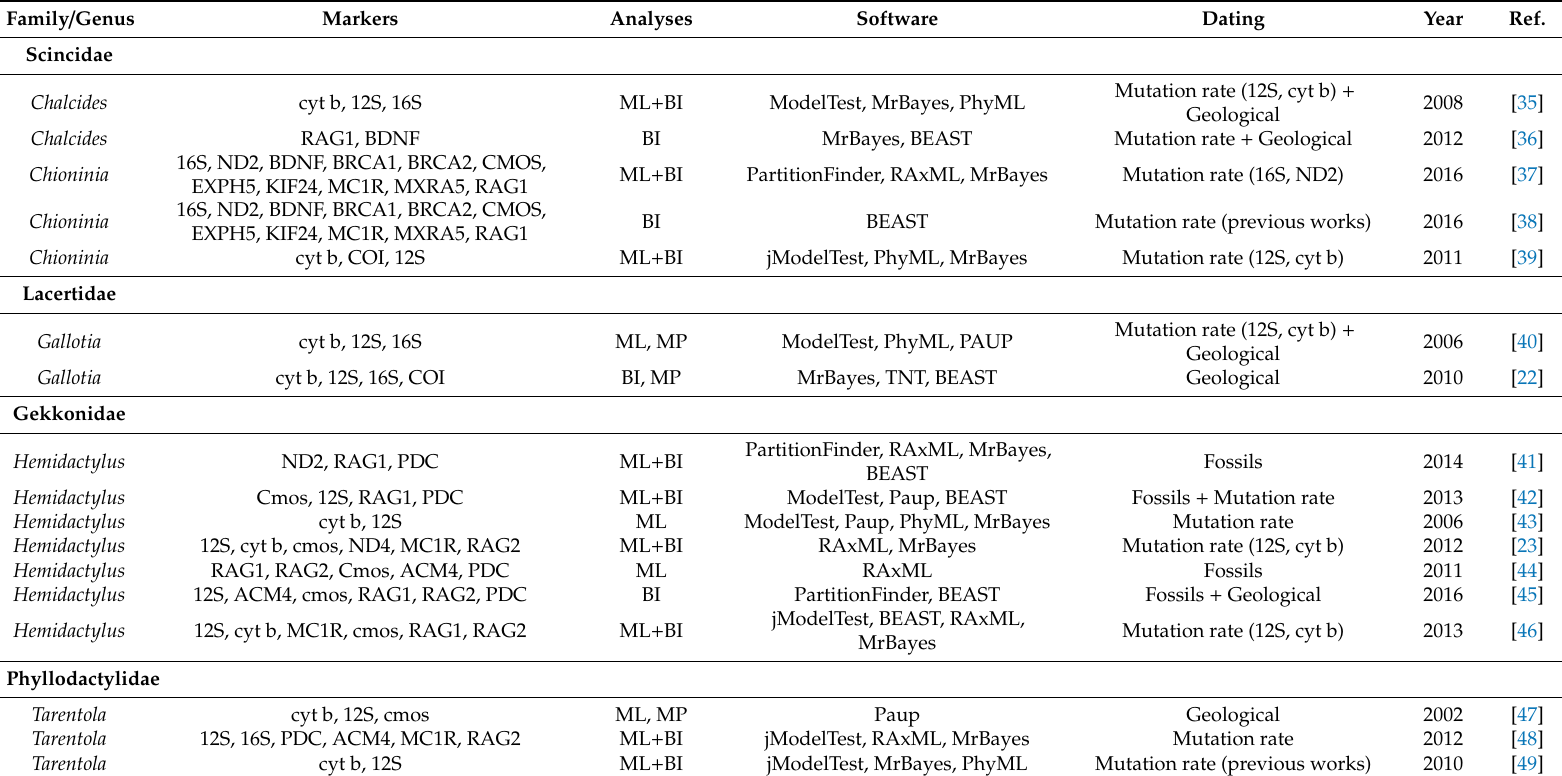
Table 1. Phylogenetic studies with Macaronesian reptiles, with molecular markers and software used, analyses conducted and corresponding bibliographic reference. Family /